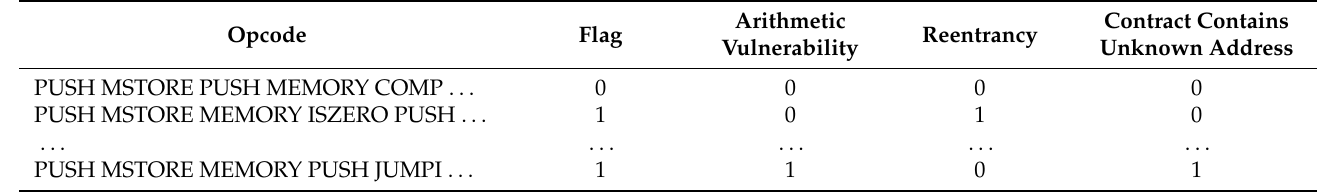
Table 4. The sample data of simplified opcodes.